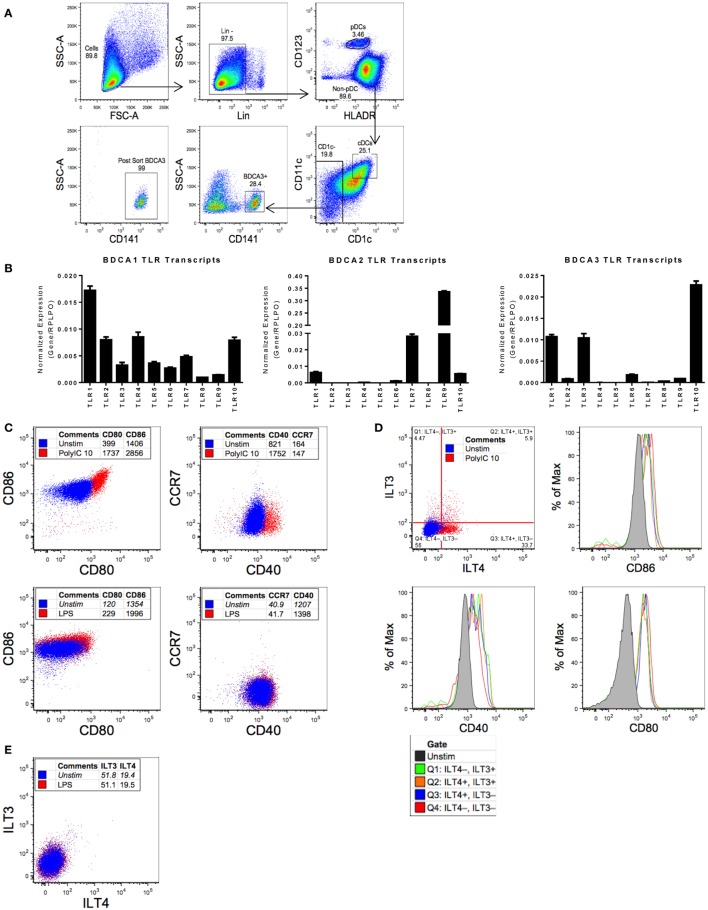
Purified BDCA-3 cDCs upon stimulation with a TLR3 agonist yield multiple populations as measured ILT3 and ILT4 expression. (A) Gating strategy for sorting human blood dendritic cells (as described in Section “Materials and Methods”). (B) RNA extracted from sorted pDCs, cDCs, and BDCA-3 cDCs was reverse transcribed for qPCR. To determine the relative expression of each gene of interest, normalized to RPLPO, the 2−ΔΔCt approach (ΔCq method) was utilized. Figure represents four donors. (C) BDCA-3 cDCs were stimulated with Poly I:C and LPS at 10 μg/mL for 18 h. Expression of CD80, CD86, CCR7, and CD40 comparing pre- and post-stimulation, blue dots represent unstimulated cells and red dots identify cells stimulated with TLR agonist, with values representing mean fluorescent intensity (MFI). (D,E) BDCA-3 cDCs stimulated with 10 μg/mL Poly I:C (D) or LPS (E) for 18 h, ILT3 and ILT4 population’s CD40, CD80, and CD86 expression compared by MFI. Data shown are one representative donor out of four.